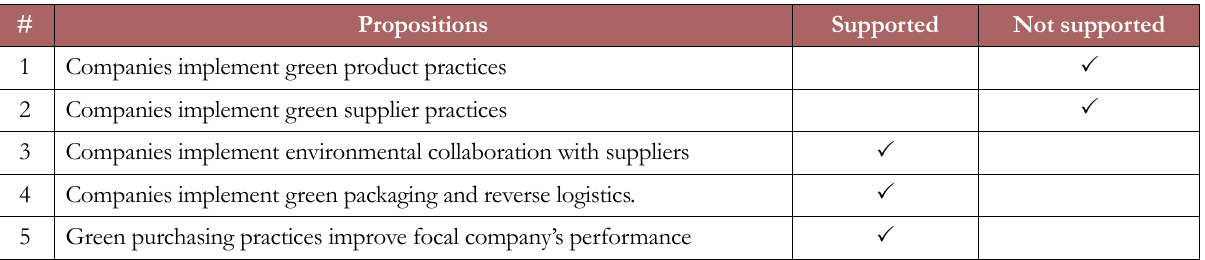
Table 4. Propositions supported and not